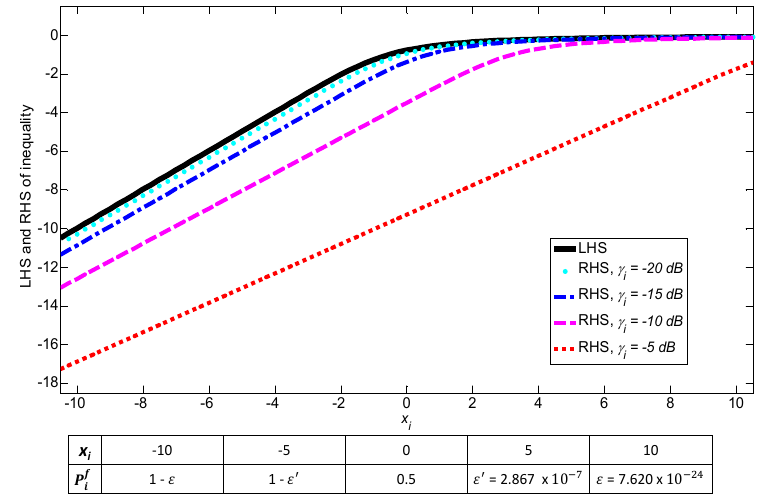
Figure 4. Under practical operating parameters, the y-axis is used to depict value for both left- and right-hand sides of inequality (9) when x i = Q − 1 represent value of P f . LHS: left-hand side; RHS: right-hand side. i